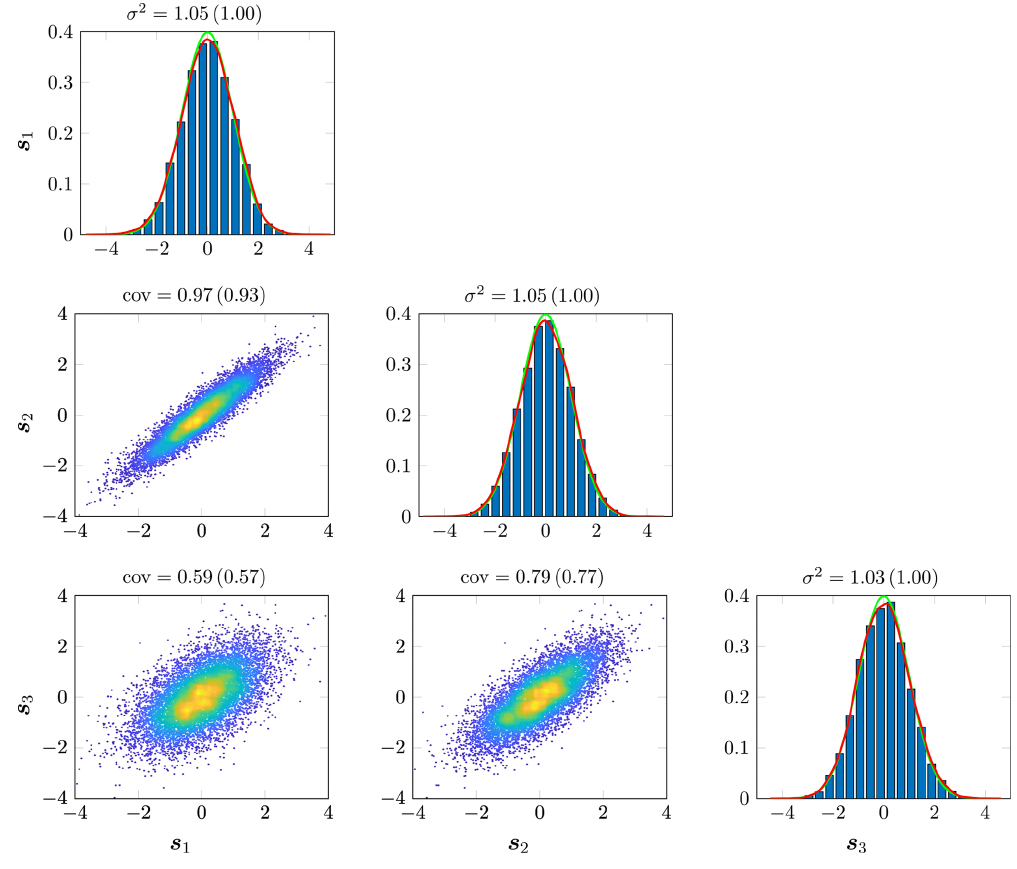
Figure 2. The same as Fig. 1 but for α = 4.